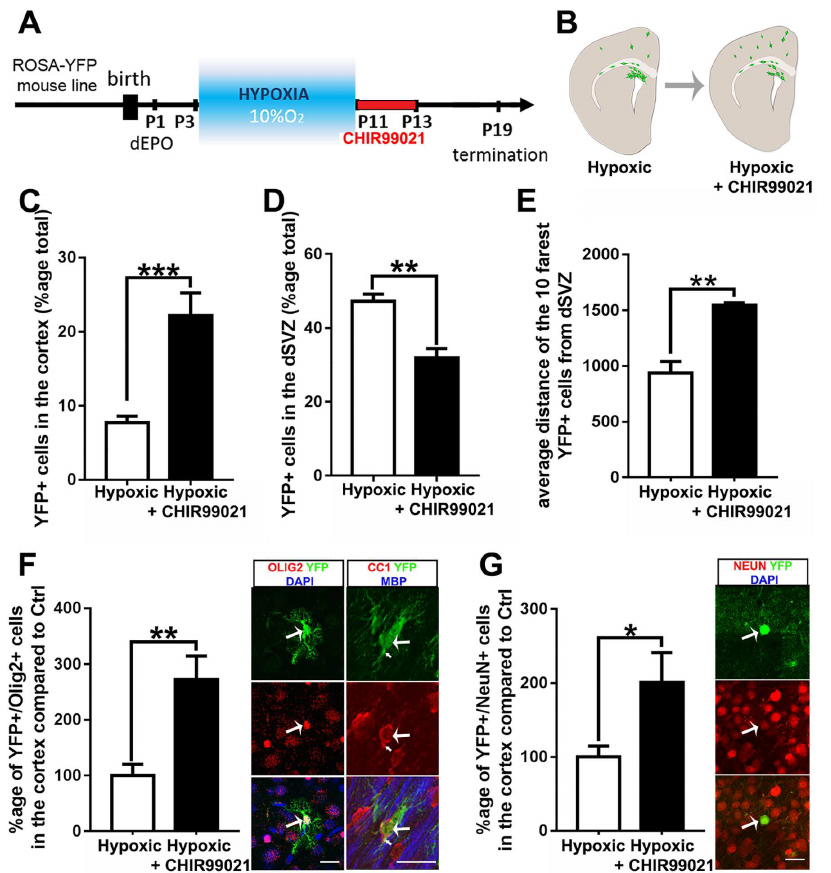
Fig 7. CHIR99021promotes dorsal subventricular zone (dSVZ)-derived cortical oligodendrocyte (OL) regeneration following chronic hypoxia. (A) Schematic representation of the experimental workflow. A Cre plasmidwas electroporated in the dSVZ of ROSA-YFP mice 1 day after birth (P1) for permanent labelingof dorsal neuralstem cells (NSCs). Mice were placedin a hypoxic chambercontaining10% O 2 from P3 to P11 then subjectedto intranasalCHIR99021administration from P11 to P13. Animalswere sacrificedat P19 for analysisof recombined cell number, migration, and differentiation. (B) Schematic representation of the results quantified in (C-E) . (C-D) CHIR99021treatment followinghypoxialeads to a decreaseof YFP+ cells in the dSVZ (C) , paralleledby a concomitantincrease in the cortex ( n = 4 for hypoxicand n = 4 for CHIR99021) (D) . (E) The averagedistanceof the ten farthest YFP+ cells from the dorsal SVZ is increasedfollowing CHIR99021treatment ( n = 4 for hypoxic and n = 3 for CHIR99021). (F-G) CHIR99021treatment promote de novo oligodendrogenesis (F) , YFP+/Olig2+, and neurogenesis (G) , YFP+/NeuN+; left confocalmicrographs followinghypoxia( n = 7 for hypoxic and n = 6 for CHIR99021). Right confocalmicrographsshow expression of CC1 in YFP+ cells in the most superficial cortical layers, supportingthe successful differentiationof the newbornOLs (large arrow) that support myelin (small arrow shows colocalizingYFP+/MBP+ myelinated fibers) in CHIR99021treated animals. *** p < 0.001; ** , p < 0.01; * , p < 0.05; t test used throughout. Scale bars = 20 μ m